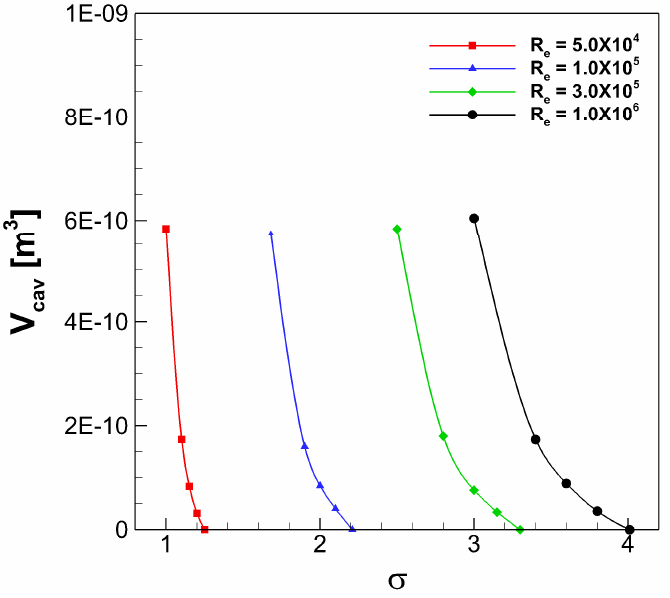
Figure 17. Cavitation volume changes with the variation of the Reynolds number and cavitation number.